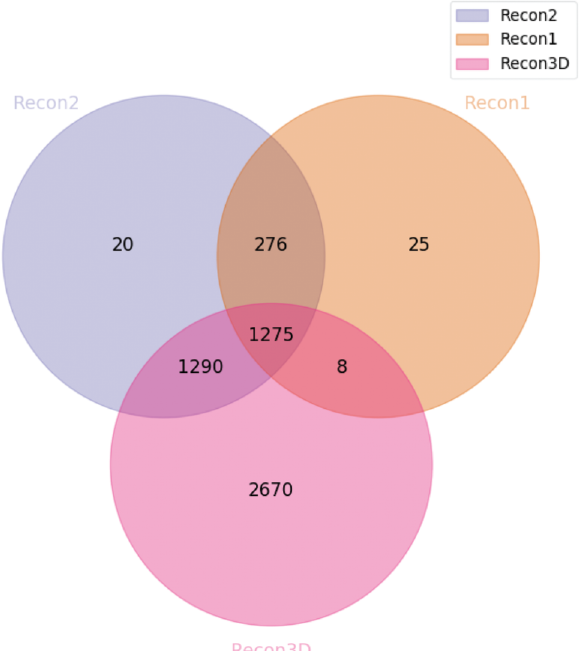
Figure 7: Venn diagram highlighting the number of reaction clusters integrated between the main three revisions of the Recon